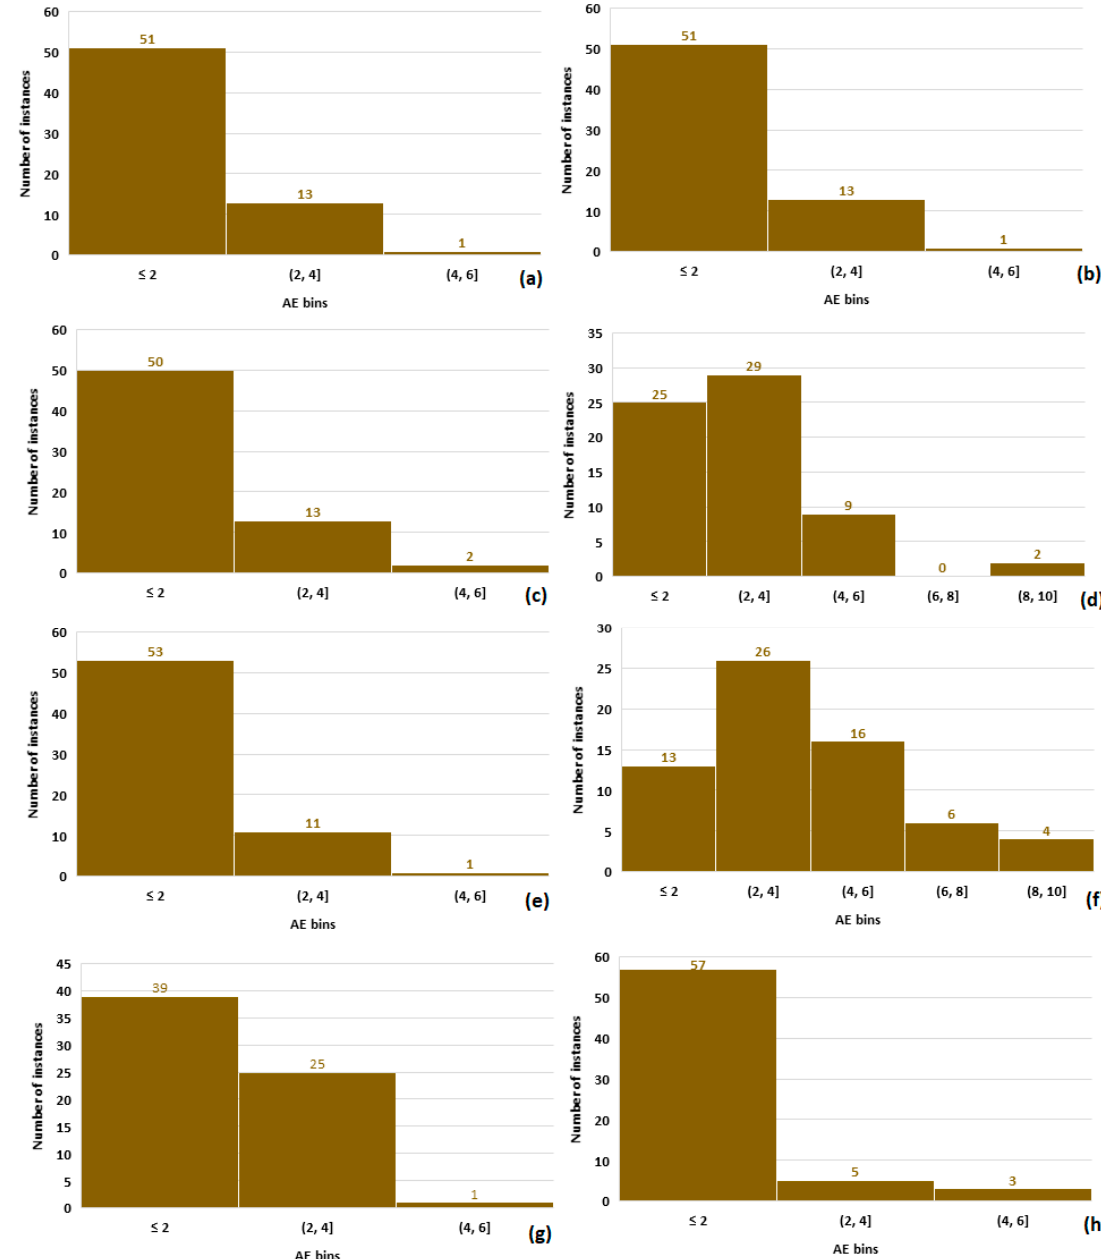
Figure 12. AE distribution for ( a ) ENN, ( b ) FFNN, ( c ) GMDH, ( d ) GRNN, ( e ) LSTM-ENN, ( f ) RBF, ( g ) RVM, and ( h ) SVR for Test Case #3.